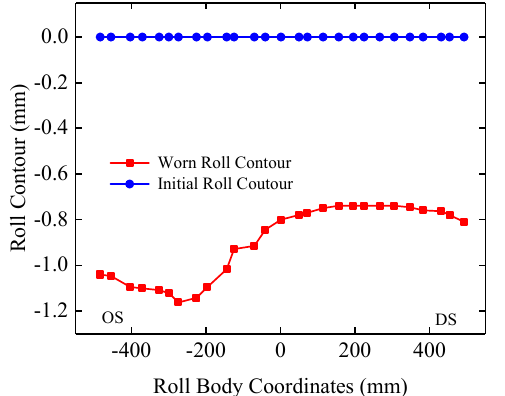
Figure 1. ( a ) Work roll contour; ( b ) original back-up roll contour.